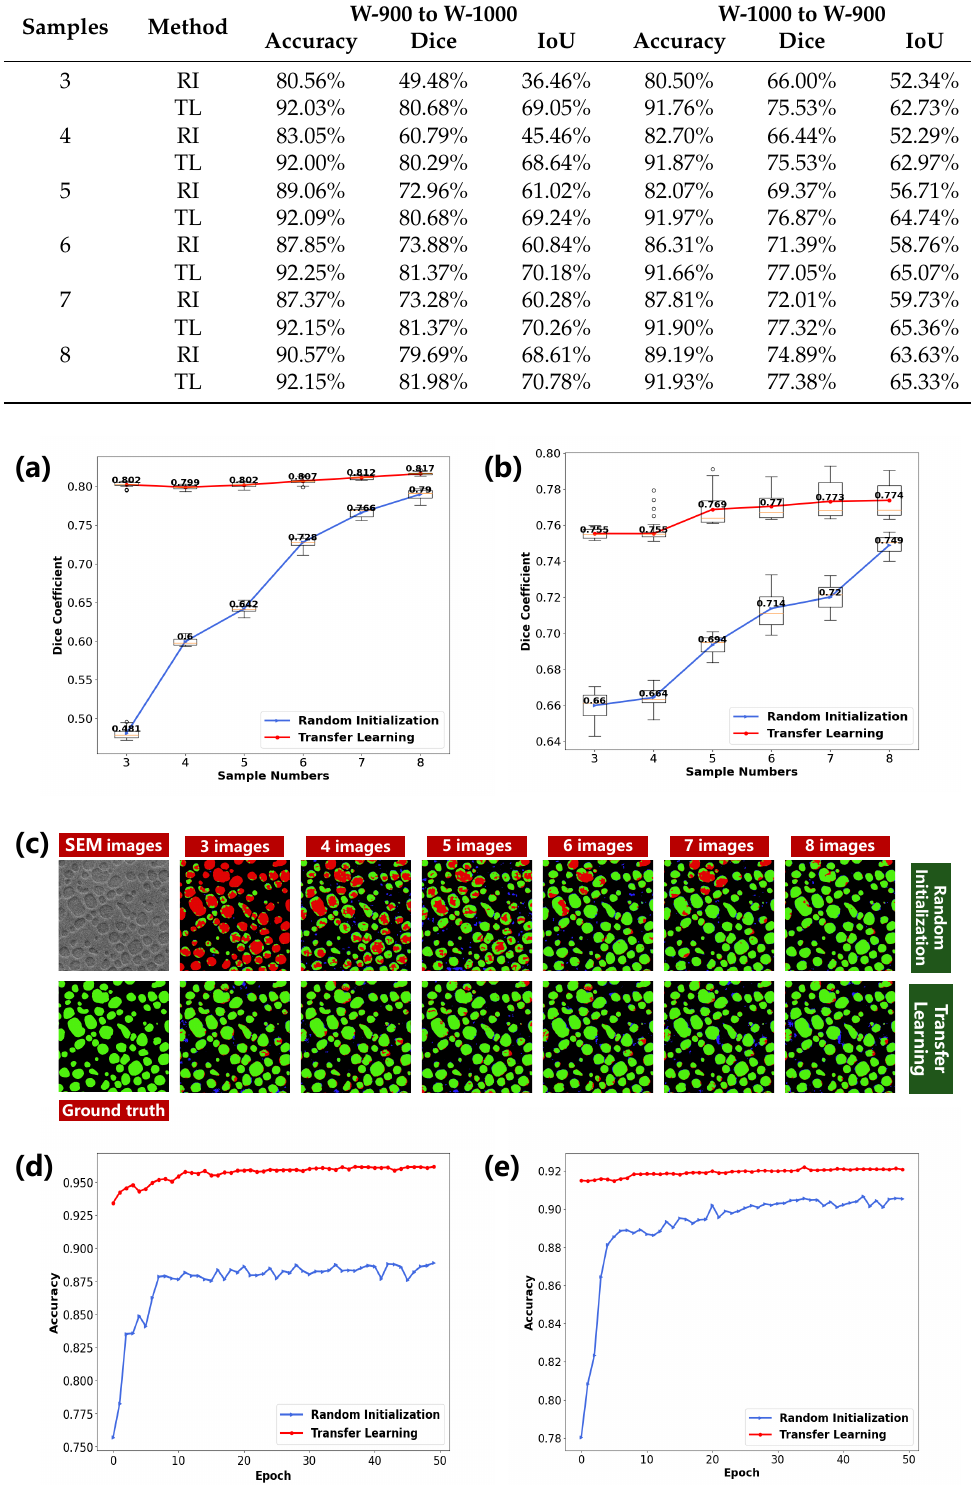
Figure 3. ( a ) The box plot of Dice-coefficient of two methods during the transfer from W-900 to W-1000; ( b ) The box plot during the transfer from W-1000 to W-900; ( c ) Visualization of recognition results; ( d ) The validation accuracy vs. different epochs of two methods during the transfer from W-900 to W-1000; ( e ) The validation accuracy during the transfer from W-1000 to